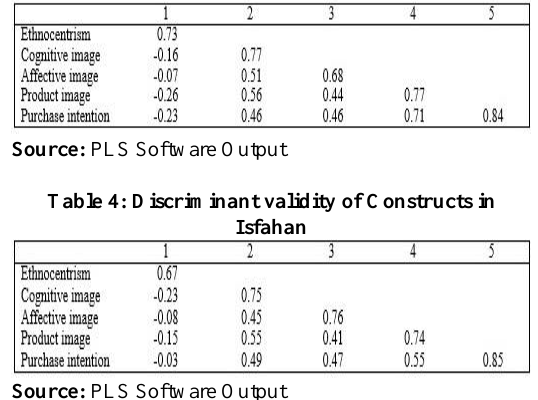
Table 3: Discriminant Validity of Constructs in Tabriz